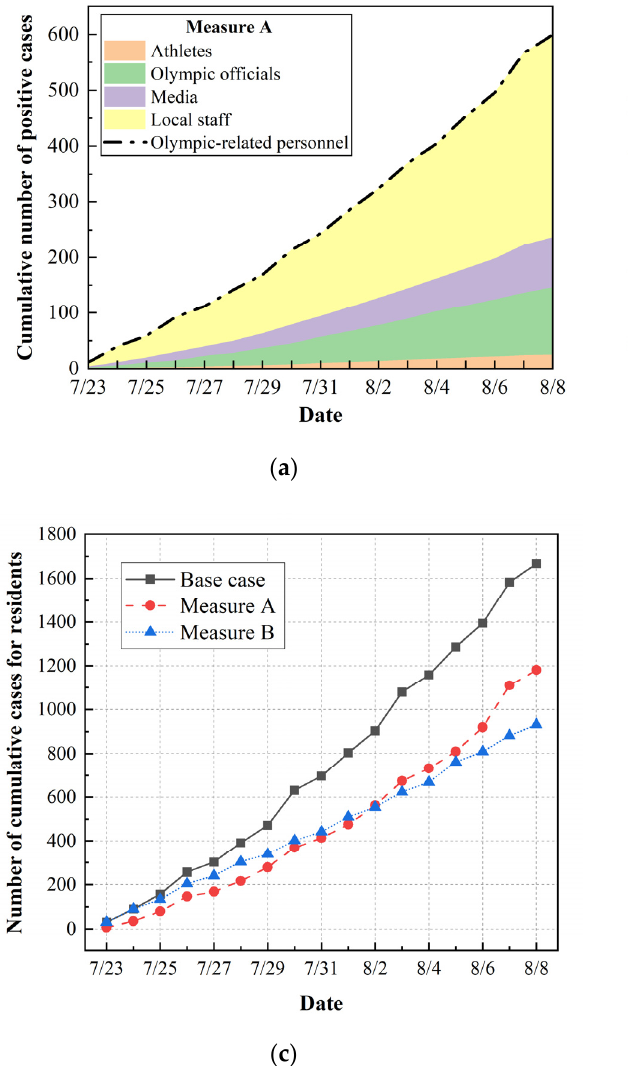
Figure 9. The predicted results under the implementation of Measure A and Measure B: ( a ) The cumulative number of positive cases for Olympic-related personnel under Measure A; ( b ) the cumulative number of positive cases for Olympic-related personnel under Measure B; ( c ) the cumulative number of positive cases for residents under Measures A and B.